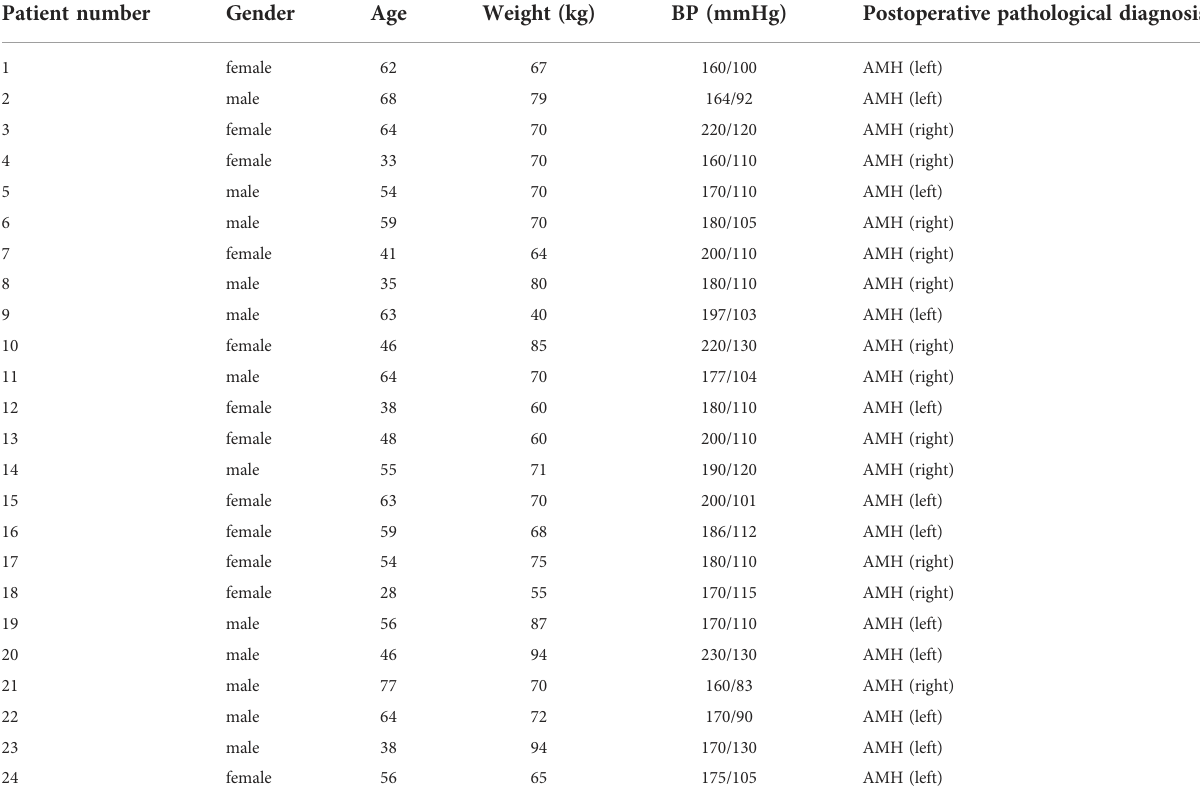
TABLE 1 Main characteristics of patients included in this